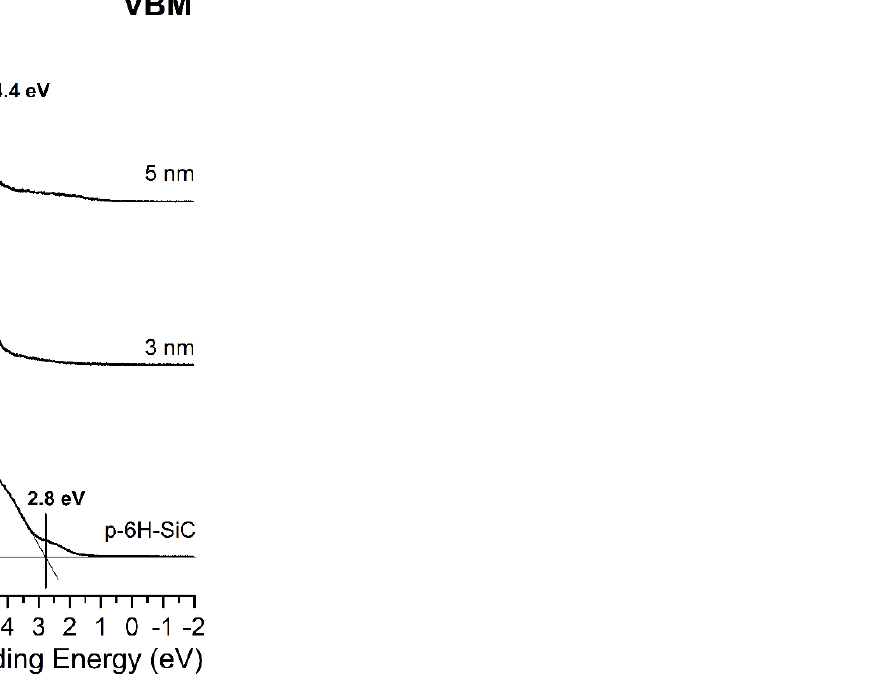
Figure 5. Evolution of UPS spectra for bare SiC(0001) surface and covered with MgO layers of an average thickness of 3 and 5 nm. The VBM of MgO remains in the same position for both coverages.